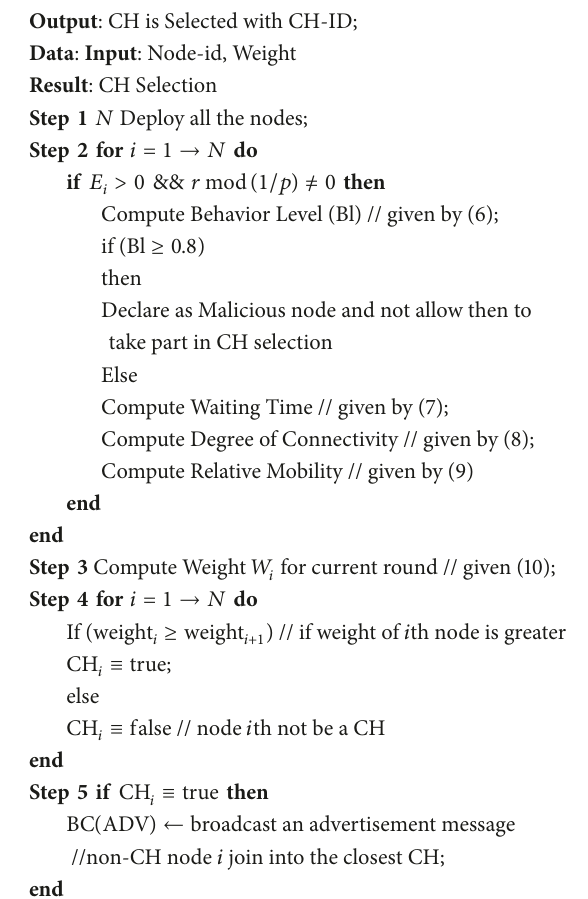
Table 2: Simulation parameters.